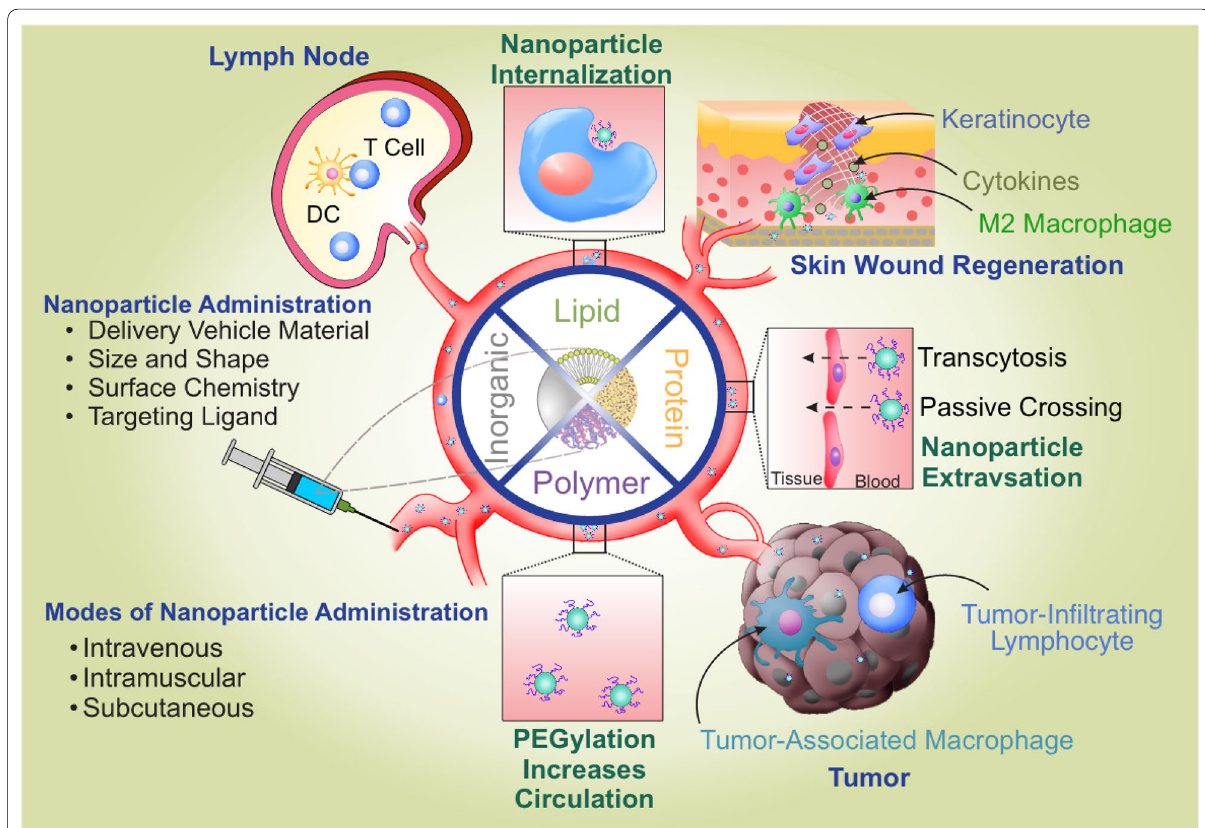
Fig. 1 Overview of nano‑immunoengineering designs and applications. Four major types of materials suited for biomedical applications include lipids, polymers, proteins, and inorganic materials. Therapeutic cargoes encapsulated in lipid coatings or grafted with poly (ethylene glycol) (PEG) can increase stability and circulation half‑life. Nanoparticles can extravasate into tumors or tissues depending on the size, shape, charge, and hydrophobicity. In the tumors, the nanoparticles could enhance T cell functions or reprogram tumor‑associated immune cells to improve anti‑tumor efficacy; in the tissues, nanoparticles engulfed by dendritic cells (DCs) could either promote host immunity or tolerance when they migrate to the lymph nodes; in injured tissues, nanoparticles could reprogram resident immune cells such as macrophages to a healing phenotype to accelerate wound